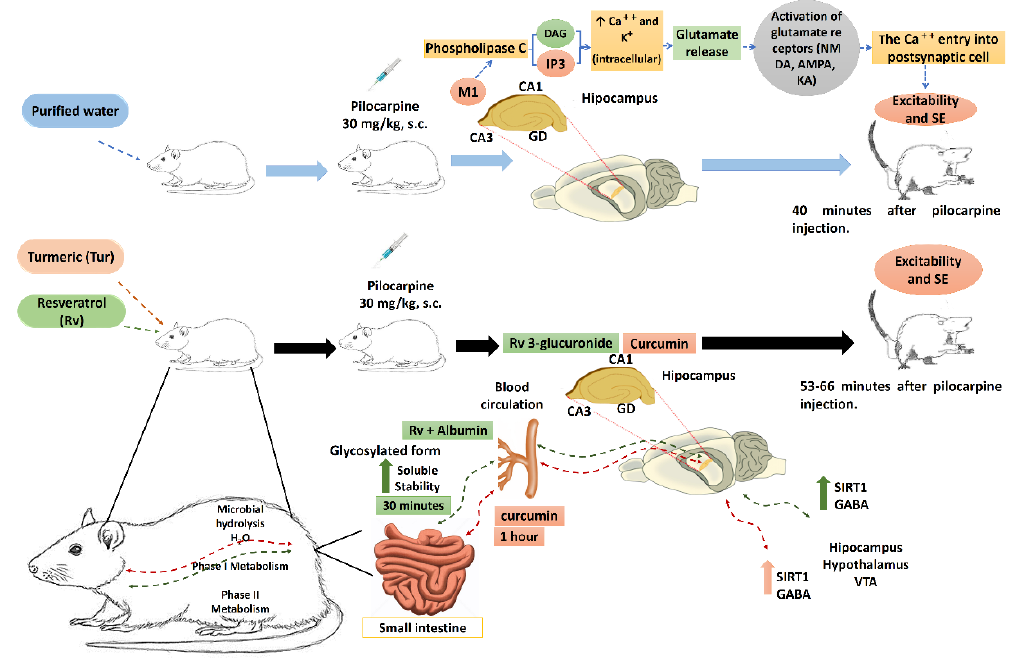
Figure 5. Theorical model of the protective mechanism of turmeric and resveratrol in status epilep- ticus (SE) induced with lithium–pilocarpine. Subcutaneous (s.c.), muscarine receptor 1 (M1), inositol triphosphate (IP3), diacylglycerol (DAG), dentate gyrus (GD), cornu ammonis (CA1 and CA3), ventral tegmental area (VTA), and sirtuin expression activator 1 (SIRT1). (Figure was prepared by the authors).